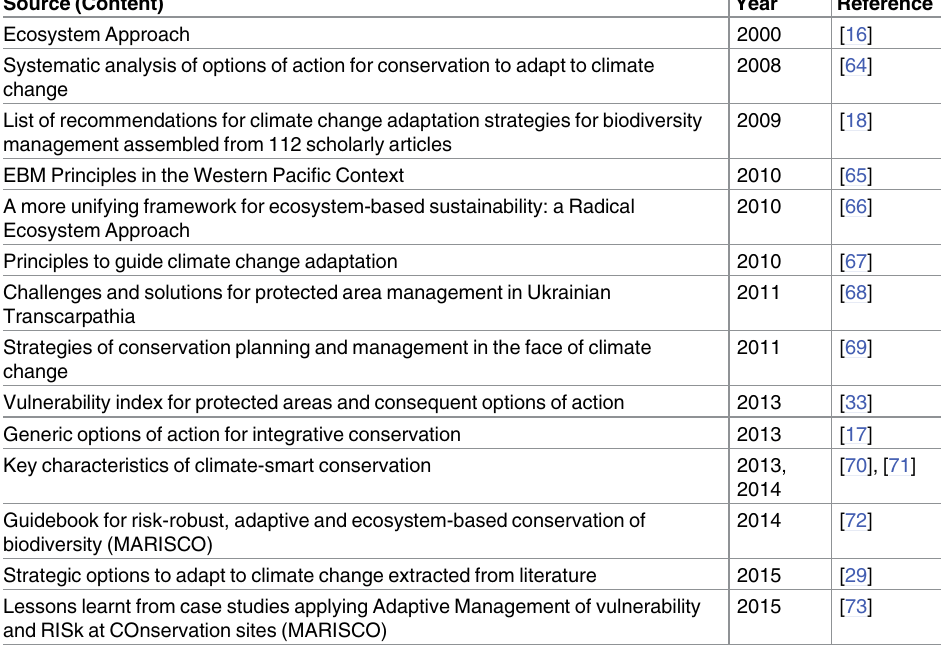
Table 2. Main sources for defining principles and criteria of climate change-robustness used in the evaluation protocol (listed in chronological